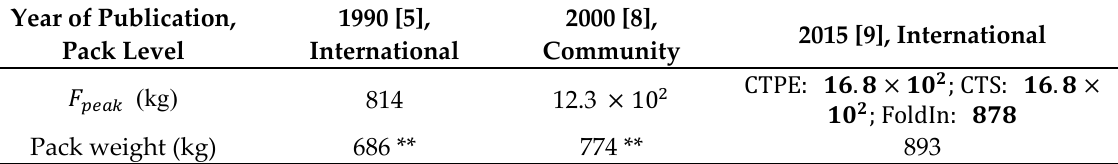
Figure 1. Scrum engagement phase evolution through time. ( a ) Configurational scheme of a scrum with player’s numbers corresponding to their positions. ( b ) Snapshot of a scrum in 1973, Ireland vs New Zealand, Test match. Front rows are in standing positions and separated by 2–3 m. ( c ) Scrum in 2000, Ireland vs France, Six Nations 2000. The apparition of first rows crouching, space between front rows remains big. ( d ) A scrum in 2019, Japan vs South Africa, World Cup 2019. A modern scrum with actual CBS referee’s calls. Before the engagement, front rows are binding with each other and the space between them is really reduced compared to older scrums. Table 1. Pack weight and peak compression force